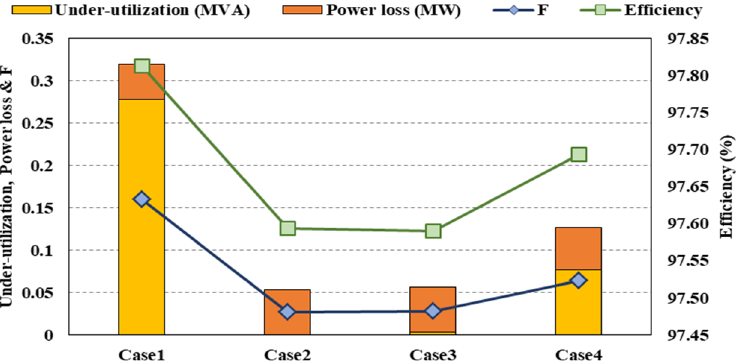
( b ) Figure 11. Performance comparison of the 69-bus autonomous distribution network at different pfsource. ( a ) Installed power generation capacity’s percent utilization. ( b ) Network’s percent load share delivered with accessible power. Conversely, for the 33-bus and 69-bus independent distribution networks, the highest power losses were produced at the power factors close to the pf source . Undoubtedly, this is be- cause of the maximum power that flows at the pf source values. The graphical illustration of the obtained results in the studied four cases for the 69-bus autonomous distribution network is presented in Figure 12. In addition, the graphical illustration of the network’s voltage profiles obtained in four cases is presented in Figure 13. The voltage profiles show that the voltages at bus 61 and neighboring buses lie close to the rated value of 1 p.u., which are due to the DG